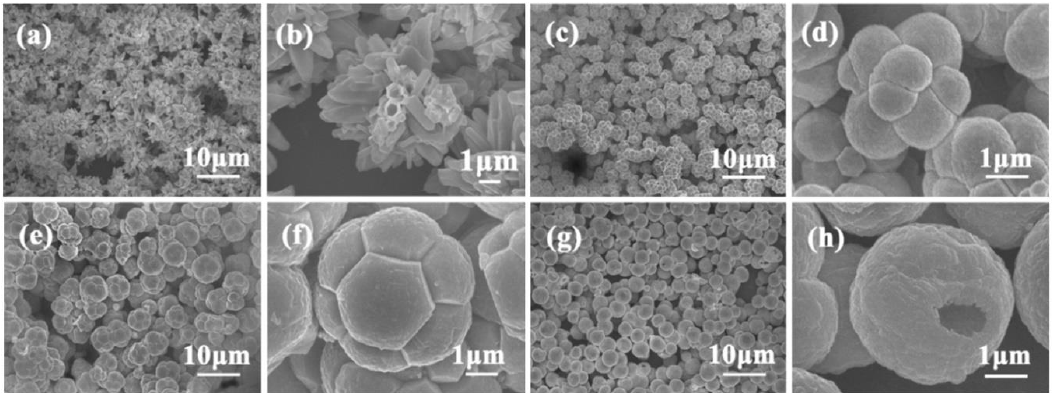
Figure 25. Products obtained with different amounts of trisodium citrate dihydrate at 90 °C for 40 min: ( a – b ) 0 mmol, ( c – d ) 0.08 mmol, ( e – f ) 0.2 mmol, and ( g – h ) 2 mmol. Republished with permission